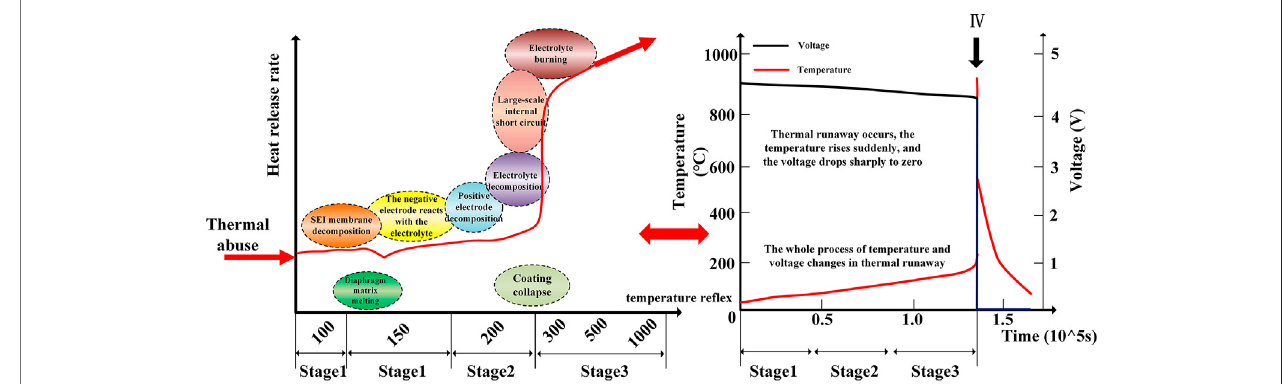
FIGURE 2 | Basic principles of thermal runaway in lithium batteries.